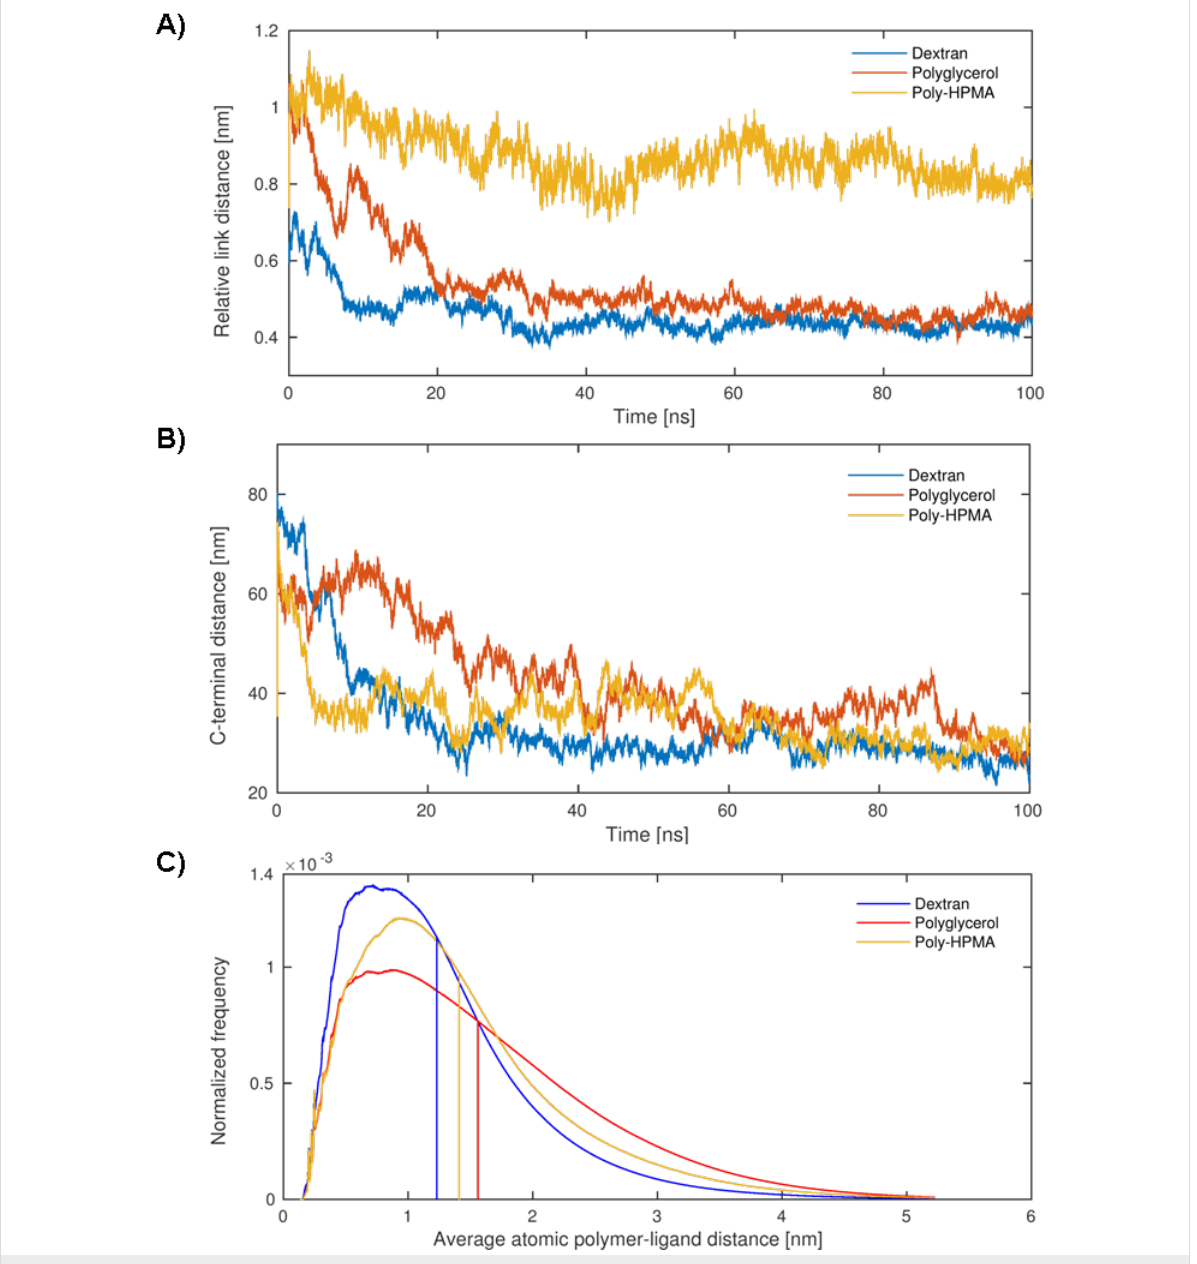
Figure 4: MD simulations over time (0–100 ns) yielding A) the mean sulfur distance between two peptides at their linking site, B) the mean nitrogen distance between two peptides at the farthest distance between peptide and polymer chain C) the frequency of observed peptide–polymer distances in dependence of the polymer backbone pHPMA, hPG and dextran,